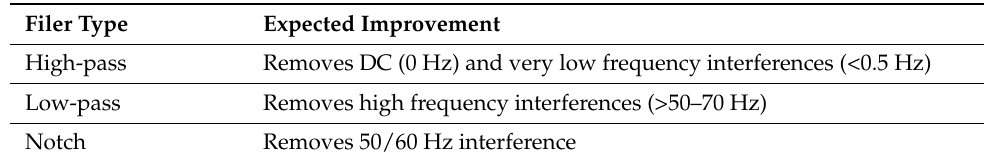
Table 2. EEG filters applied to raw EEG